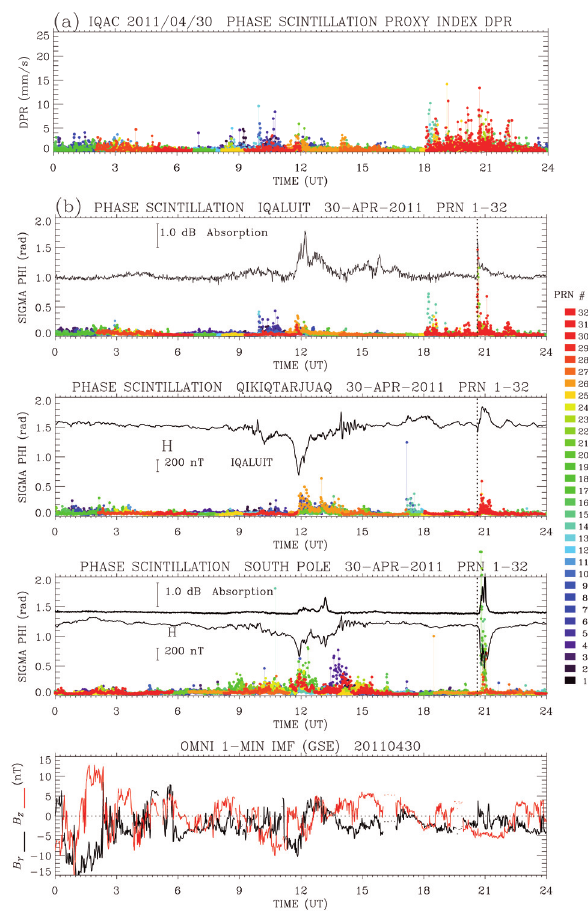
Figure 6. (a) The scintillation proxy DPR index for IQA on April 30, 2011. (b) The phase scintillation index v U observed at elevations above 30°. The riometer absorption and the H components of the ground magnetic field measured at IQA and SP are superposed in the scin- and B are shown in the bottom tillation panels. The IMF B Y Z